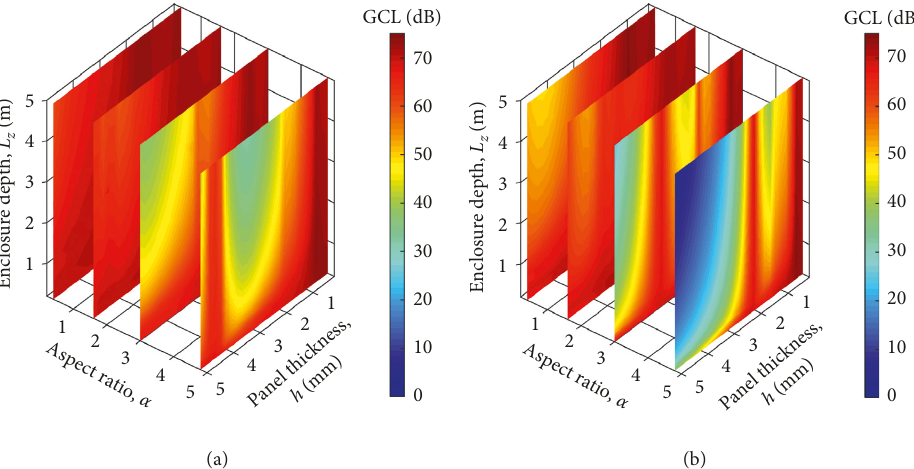
Figure 13: Comprehensive effect of structural parameters on global coupling level of the coupled system: panel aspect ratio α and 4.8. (a) Simply supported panel. (b) Clamped panel.